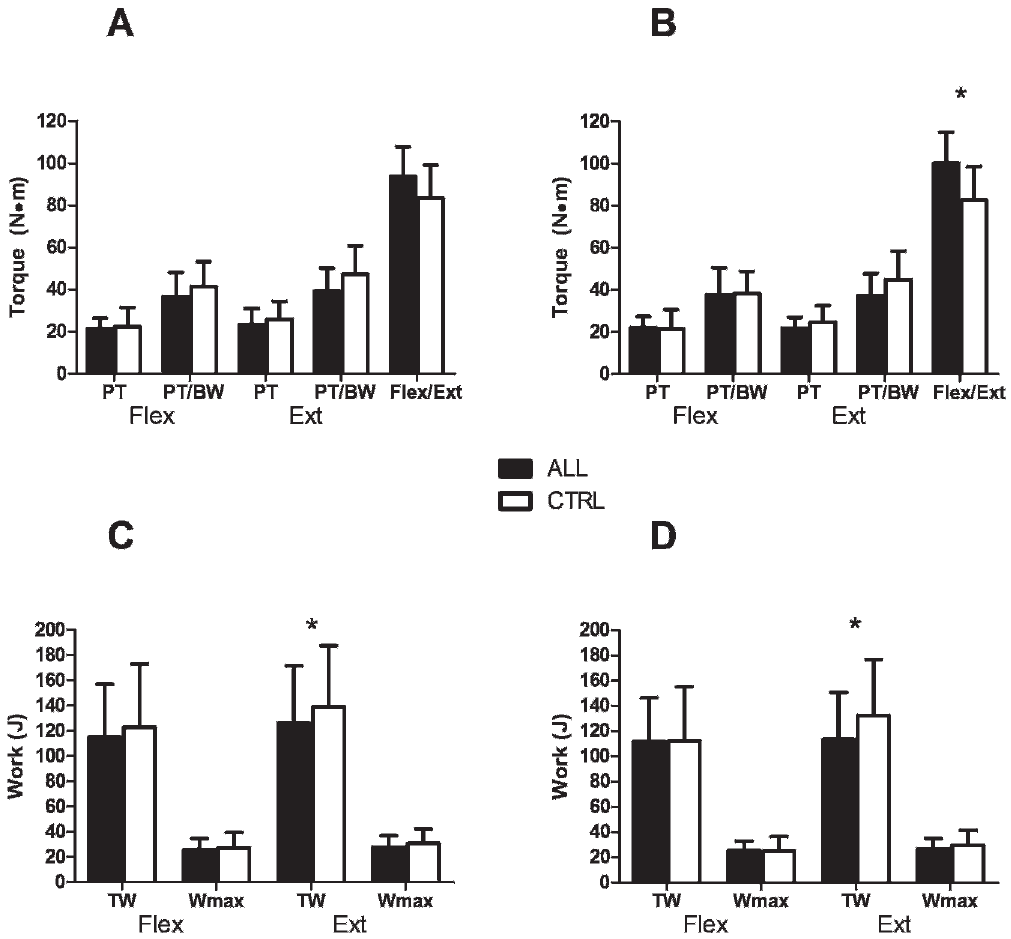
Figure 2 - Elbow flexor and extensor isokinetic strength measurements for the right (panels A and C) and left (panels B and D) limbs. PT, peak torque; PT/BW, peak torque normalized to body weight; Flex/Ext, balance between flexors and extensors; TW, total work; Wmax, maximum work performed during a single repetition. *, p , 0.05 for